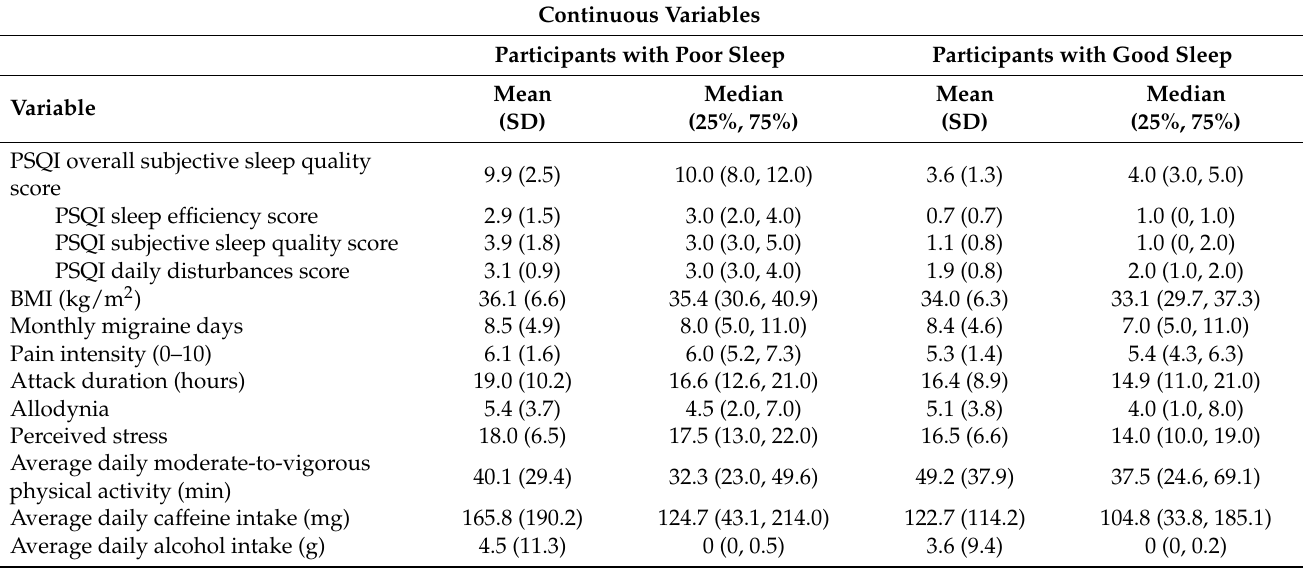
Table 3. Descriptive characteristics for variables of interest for individuals with poor vs. good